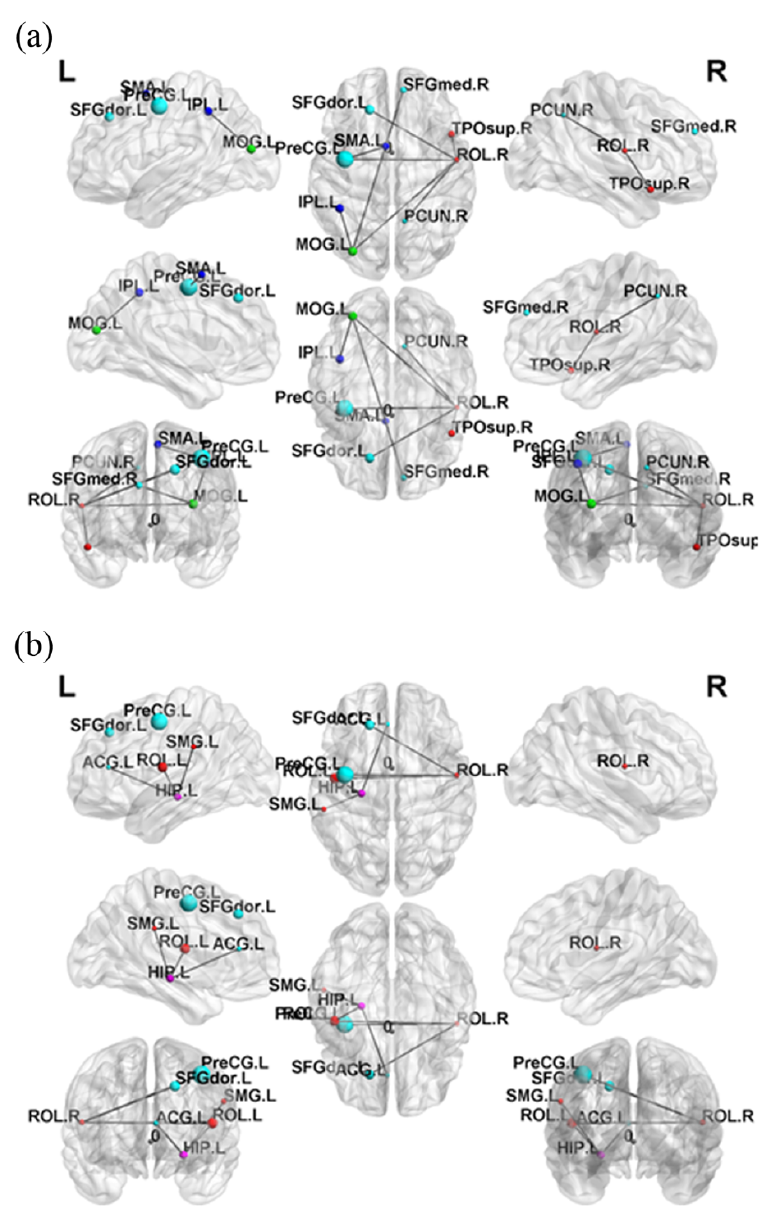
Figure 4. Network-based statistical analysis (NBS) results. ( a ) Compared with the HC group, the SA group demonstrated significantly stronger subnetwork connections in the frontal and parietal lobes. ( b ) Compared with the HC group, the D group demonstrated significantly stronger subnetwork connections in the parietal lobe ( p < 0.05).